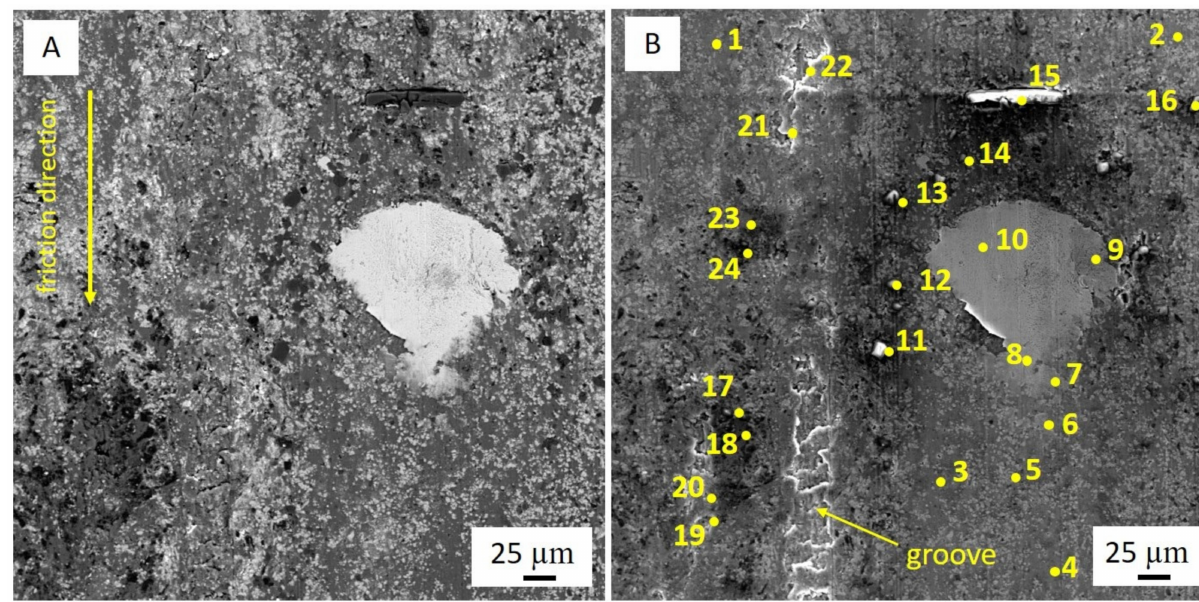
Figure 8. BSE ( A ) and SE ( B ) mode with EDS analysis points SEM images of the Al–Cr alloy after friction test.